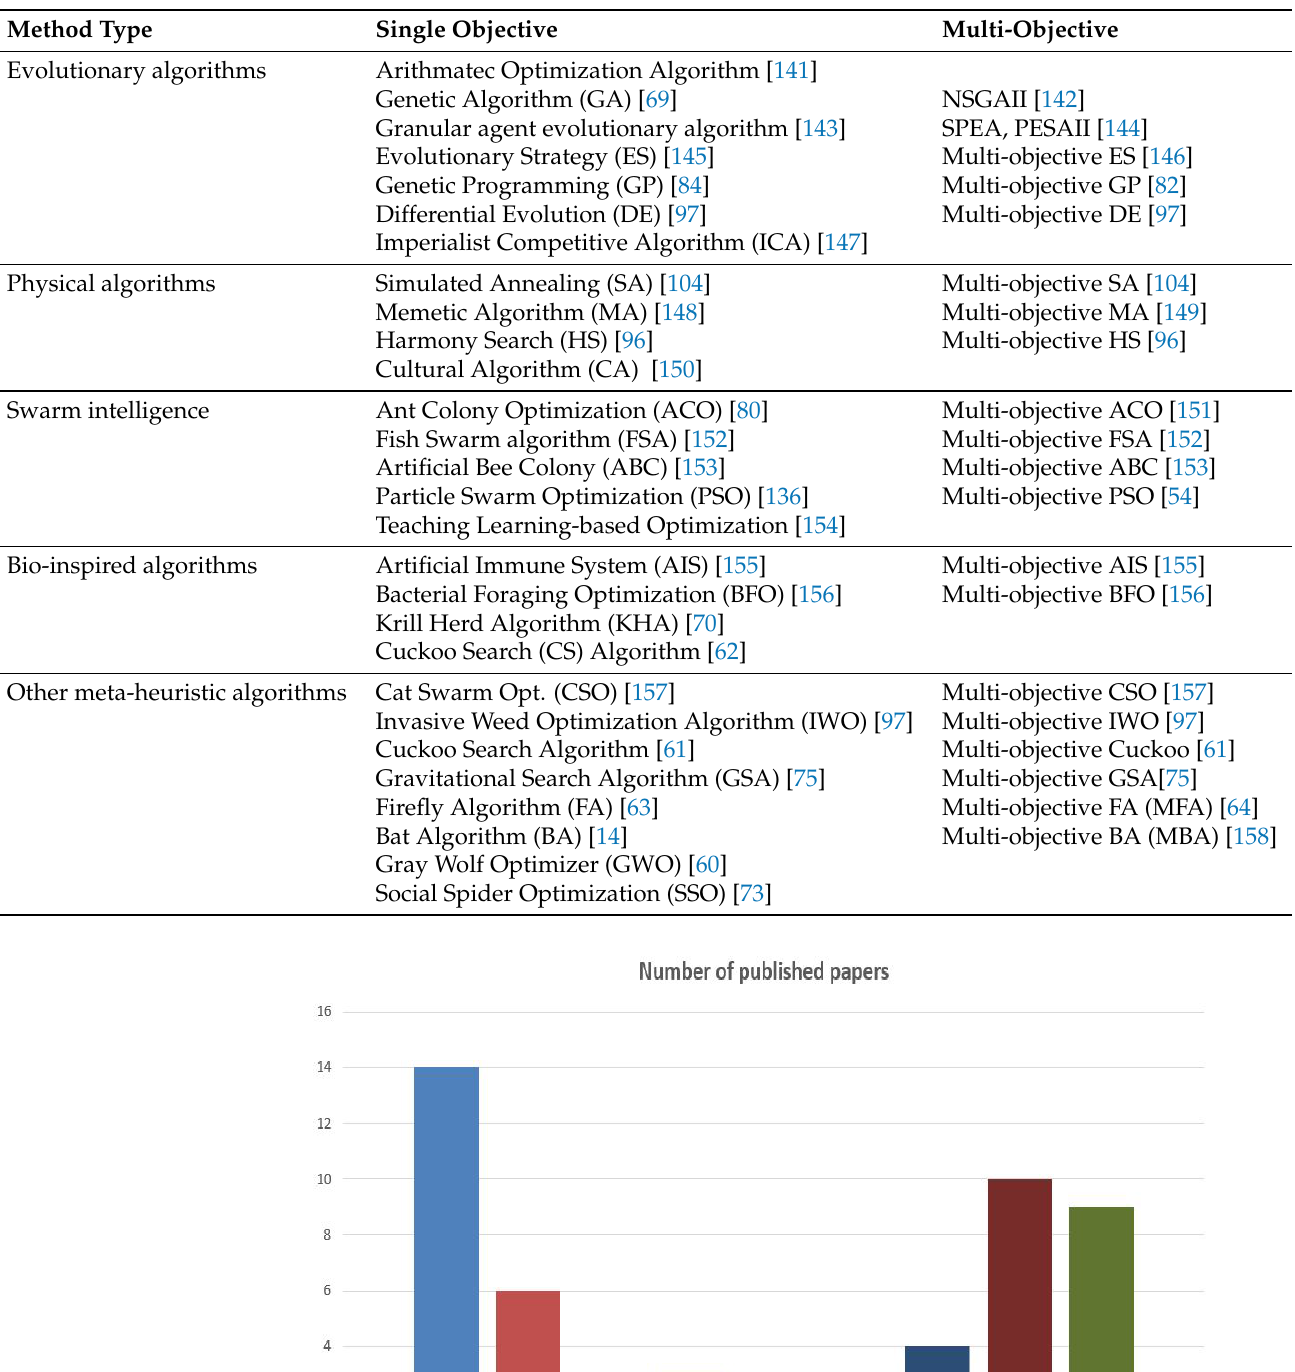
Table 1. The general classification of meta-heuristic optimization algorithms.